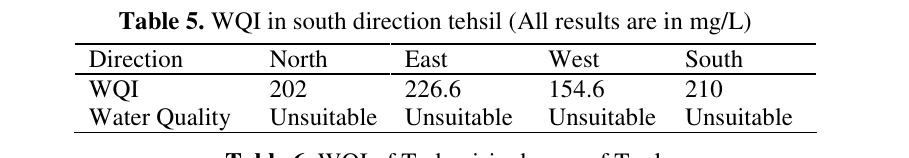
Table 4. WQI in west direction of tehsil